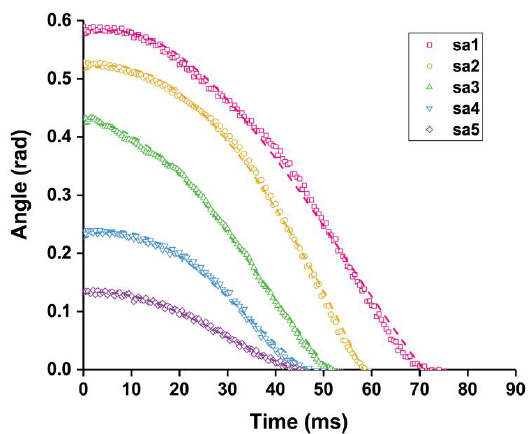
Figure 5. Angle changes with panel angle θs variation. When the angle between the two panels increases, the angles of motion are changed because the radius of the motion is decreased.